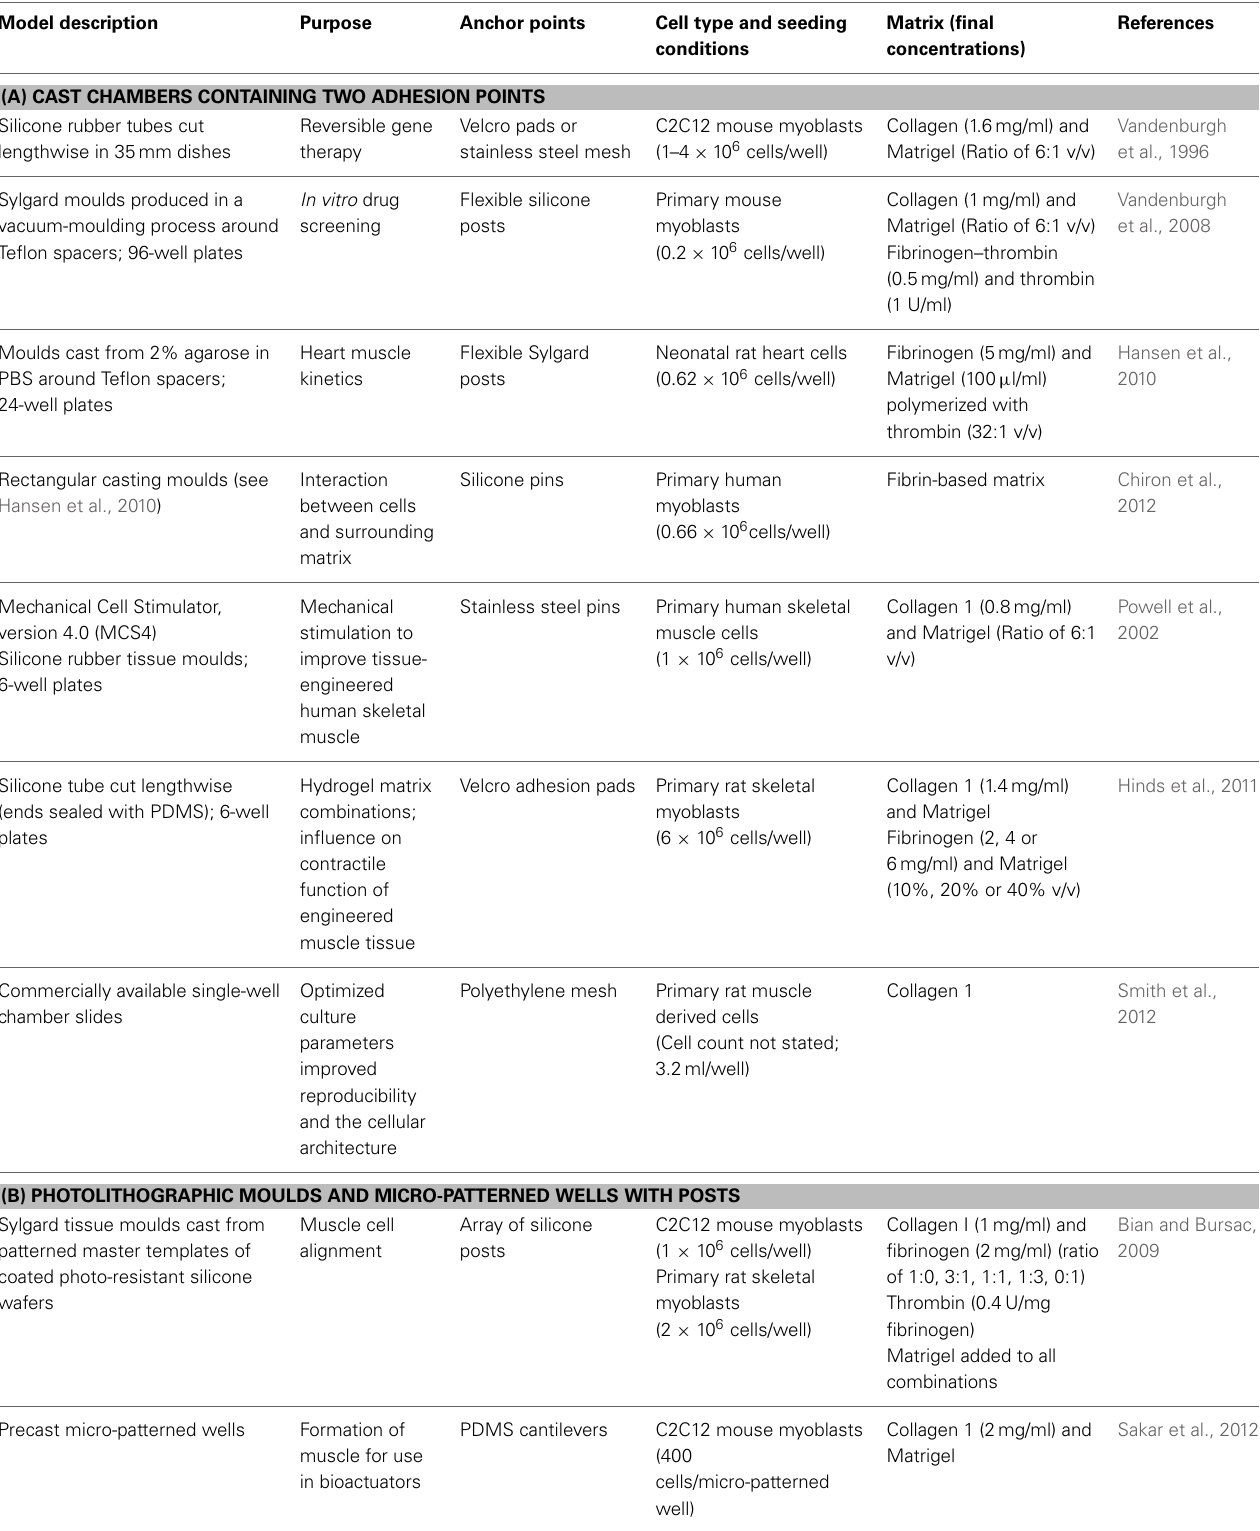
Table 1 | A comparison of published methods for the generation of bio-artificial skeletal